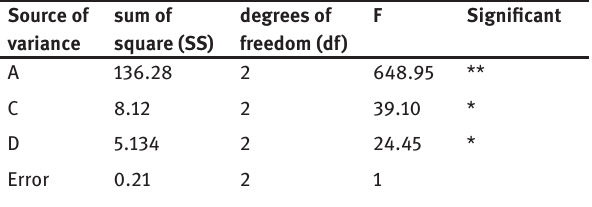
Table 4: Variance analysis results.